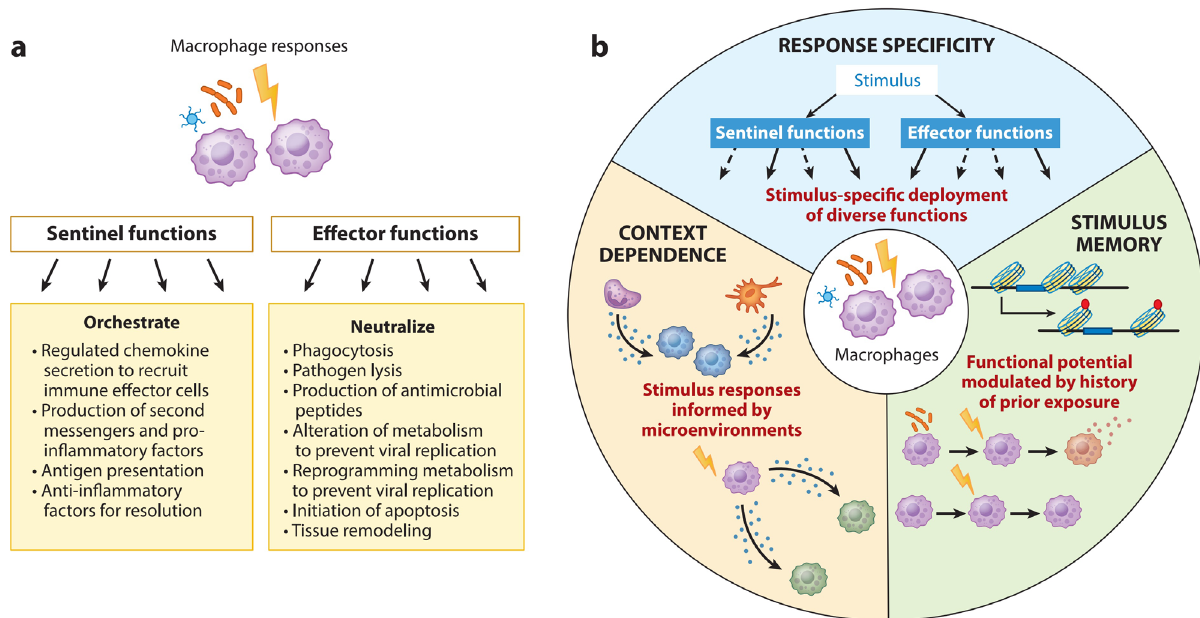
Figure 1. Functional characteristics of macrophages. (A) As a response, macrophages engage in a variety of functions. They might act as immune system guards or immunological effector cells, depending on their function; (B) macrophage responses have three characteristics of immunological activity: response specificity, context reliance, and stimulus memory. Solid and